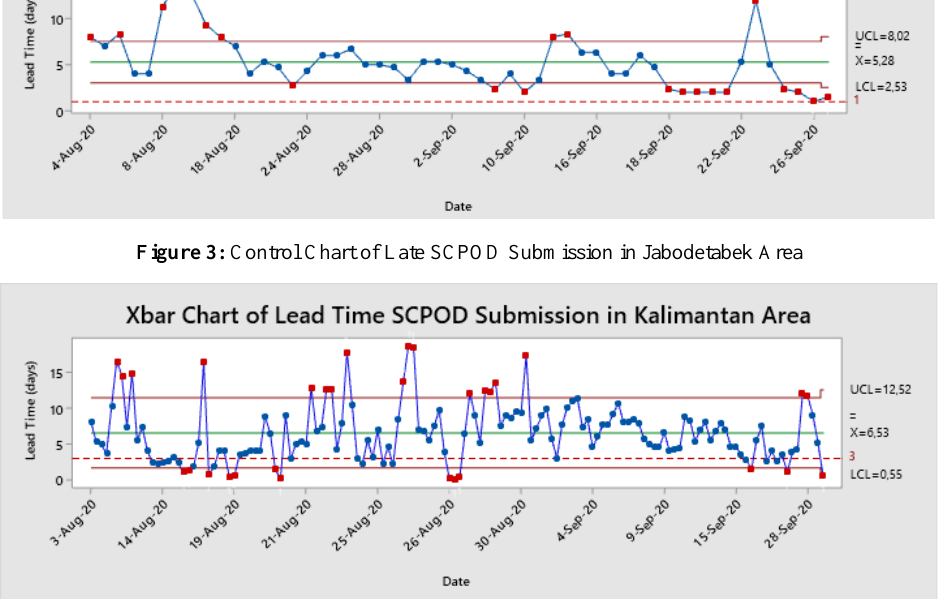
Figure 4: Control Chart of Late SCPOD Submission in Kalimantan Area